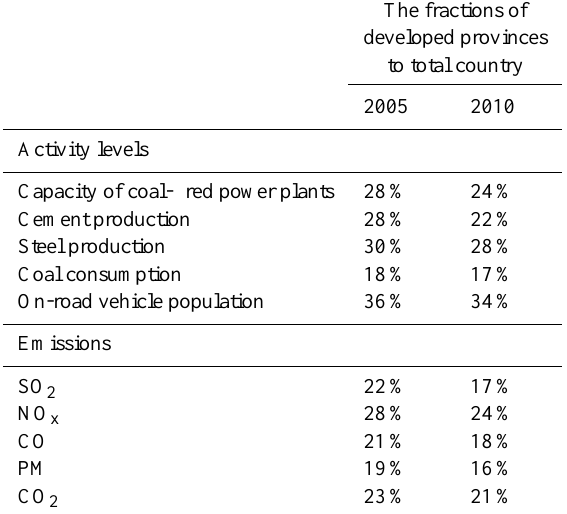
Table 5. The fractions of the sum of developed provinces (including Beijing, Tianjin, Shanghai, Jiangsu, Zhejiang, and Guangdong) to total country in activity levels and emissions for 2005 and